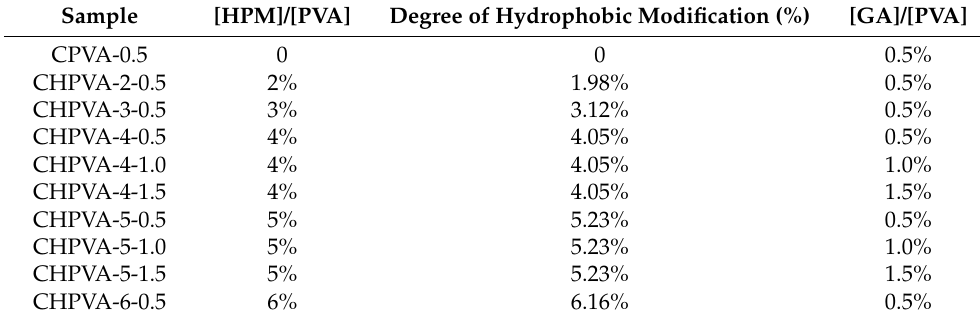
Table 1. Synthesis of the copolymer (HPVA) and hydrogels